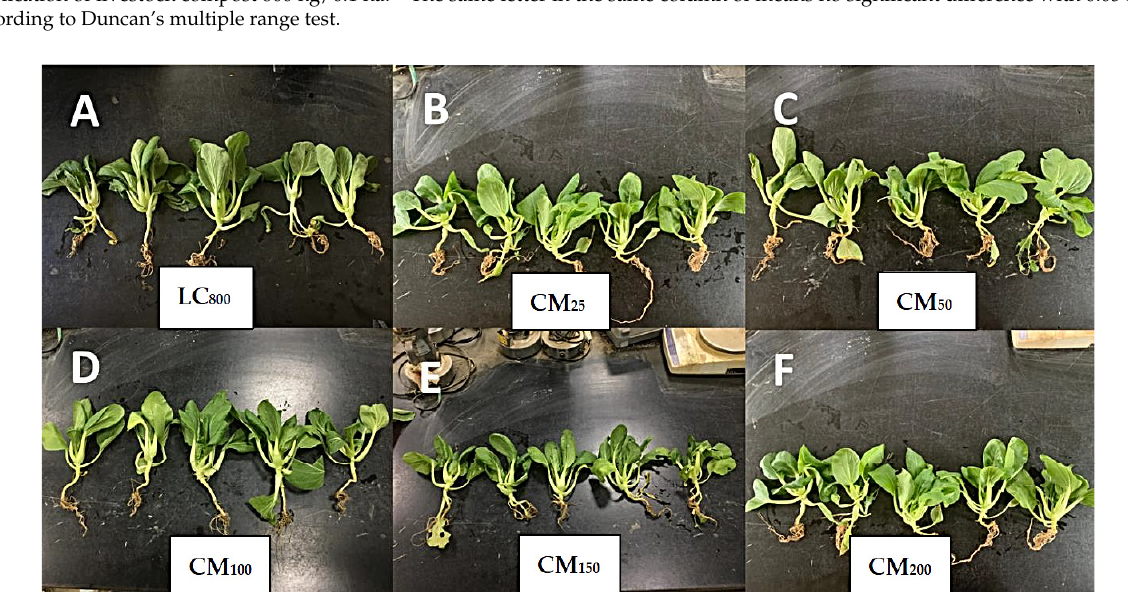
Figure 1. The growth of Pak Choi ( Brassica chinensis L.) by the treatments of organic fertilizers. ( A ) LC 800 , ( B ) CM 25 , ( C ) CM 50 , ( D ) CM 100 , ( E ) CM 150 , ( F ) CM 200 . CM 25 , CM 50 , CM 100 , CM 150 and CM 200 represent the rate of castor meal 25, 50, 100, 150 and 200 kg/0.1 ha. LC800 represented the application of livestock compost 800 kg/0.1